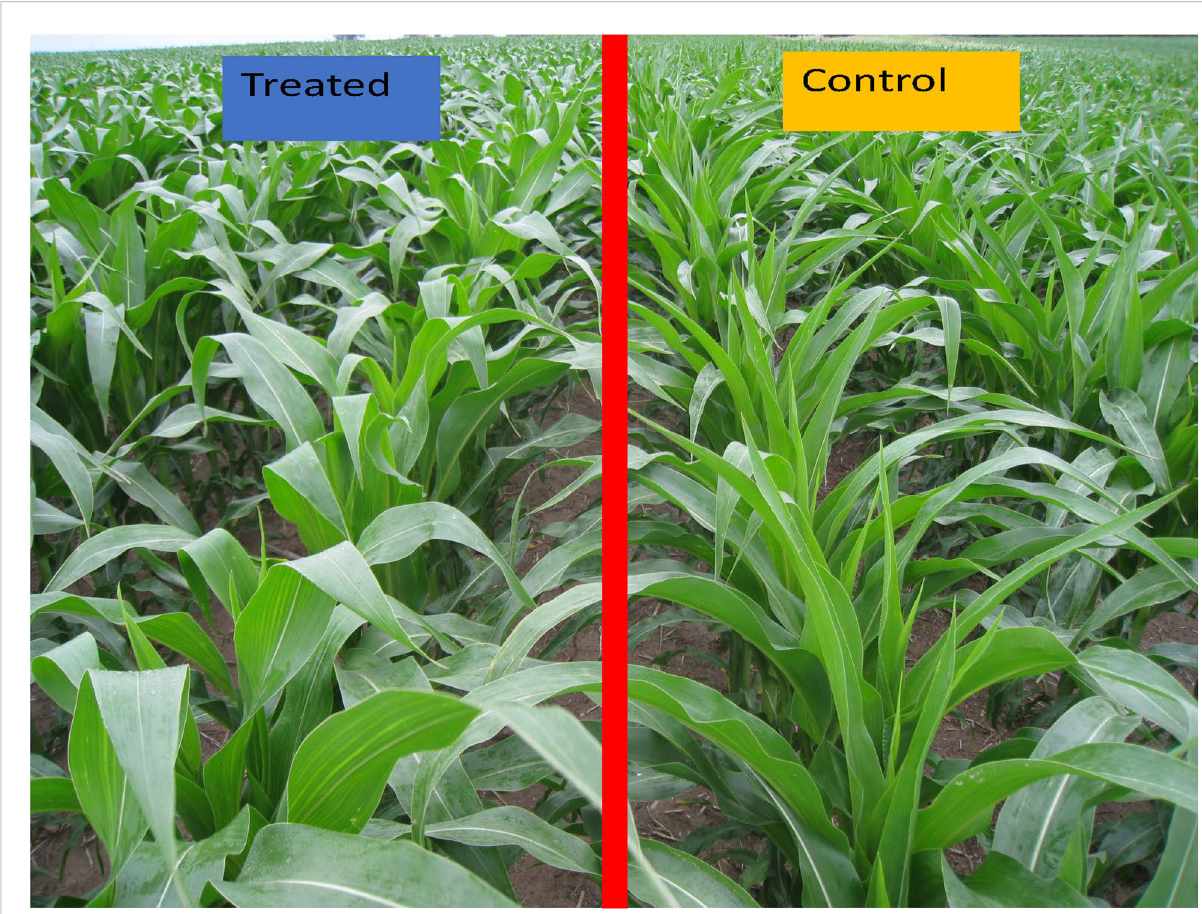
FIGURE 3 Prevention of wilting in maize at a vegetative growth stage when amended with the humic product (left), compared to the unamended control (right), droughty 2012